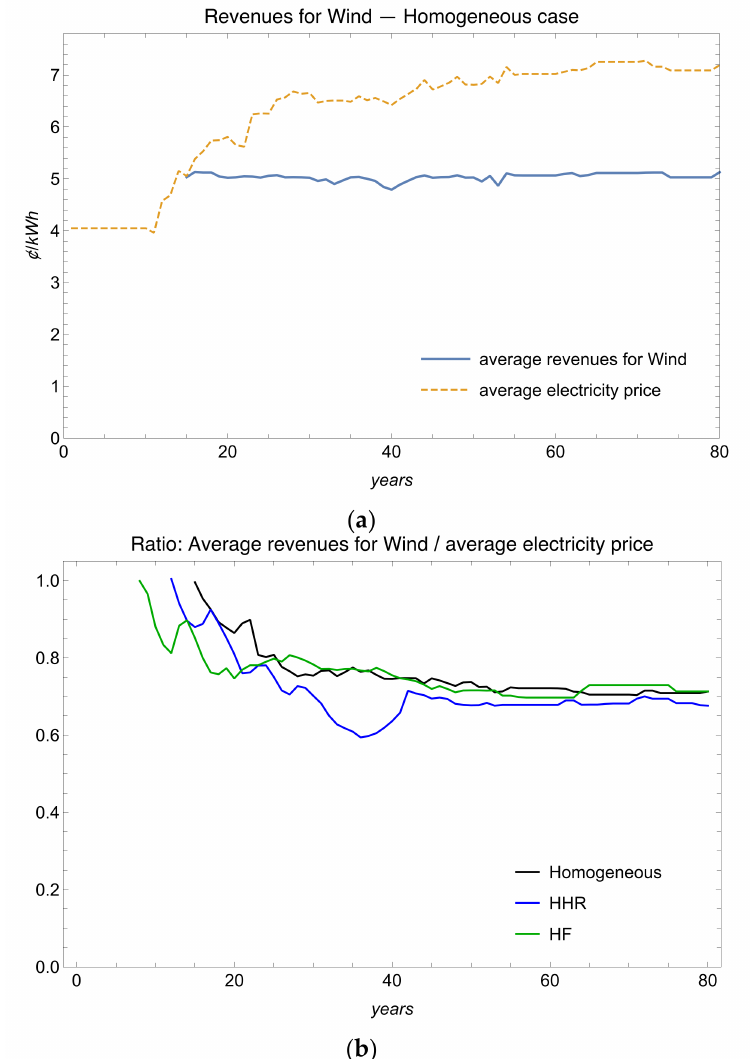
Figure 6. Revenues received by wind: ( a ) in absolute term (homogeneous case), ( b ) in relative term (all three